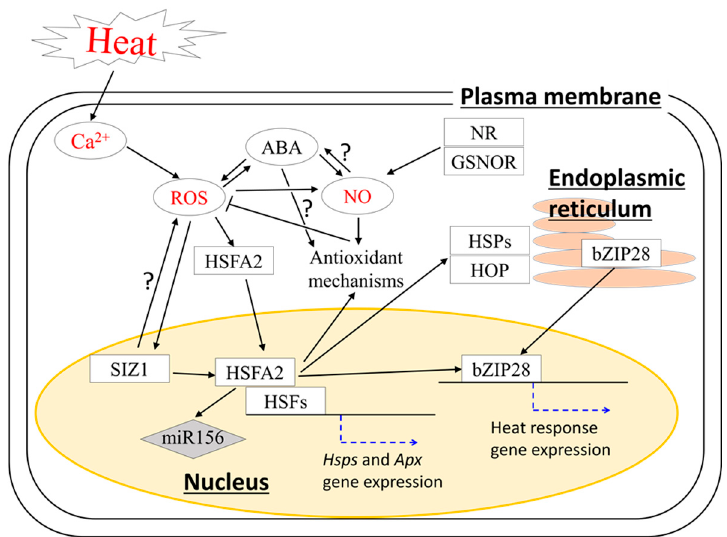
Figure 2. Simplified model of signaling pathway governing acquired thermotolerance in plants. Heat shock transcription factors (HSFs), including heat shock transcription factor A2 (HSFA2), modulated by a network of ROS, Ca 2+ , and NO signaling, might function as master regulators of this pathway. HSFA2 might be also regulated by small ubiquitin-like modifier (SUMO)ylation via the function of SUMO E3 ligase (SIZ1). Basic leucine zipper protein 28 (bZIP28) might act as a downstream signal of HSFA2 activated by ROS signaling. Rectangles indicate proteins; the gray diamond indicates microRNA (miRNA); ellipses indicate other signaling molecules, e.g., Ca 2+ ions, ABA, ROS, and NO; black arrows indicate positive regulation; T-shaped lines indicate negative regulation; blue dotted arrows indicate activation of gene expression; yellow circle indicates the nucleus; orange ovals indicate the endoplasmic reticulum. Heat stimuli and key signaling molecules (Ca 2+ , ROS and NO) are indicated in red characters. Names of cellular components are indicated in underlined characters. The pathways that can be hypothesized but not clearly evidenced in previous studies are marked with “?”.